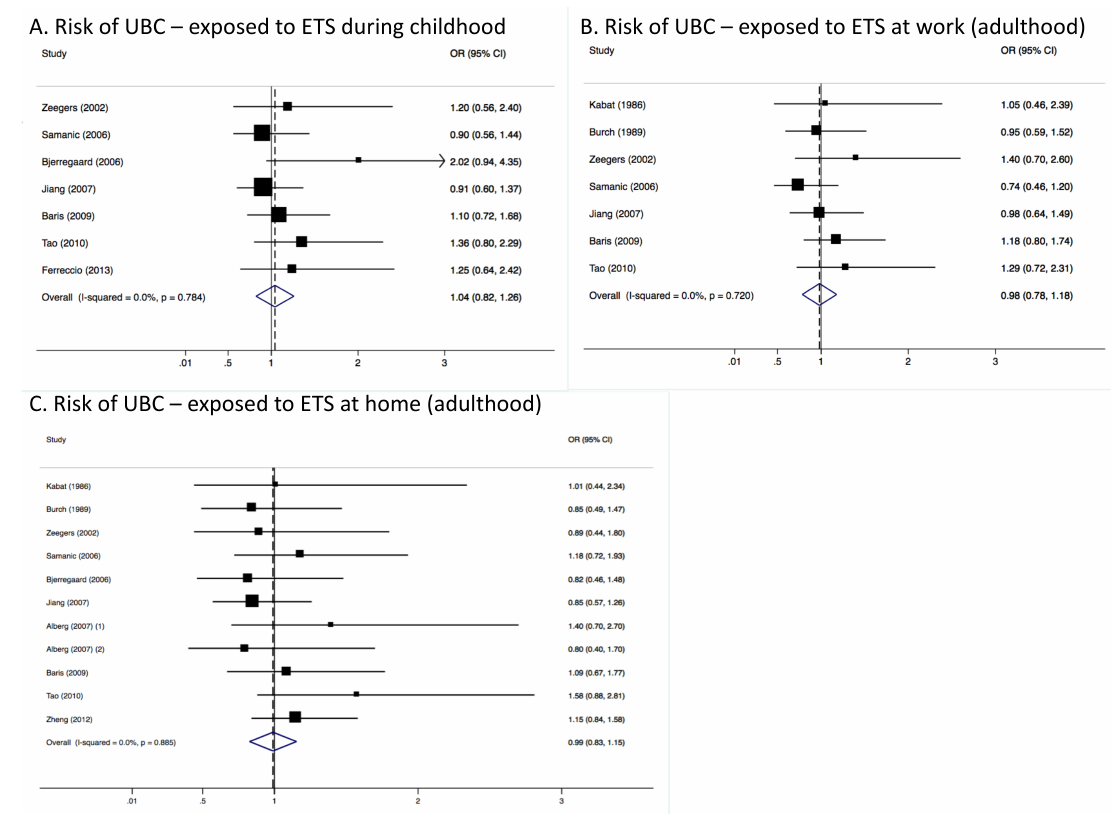
Figure 1. Meta-analysis results showing pooled risk estimates for urothelial bladder cancer (UBC) stratified by timing (childhood or adulthood) and location (work-related or domestic) of exposure to ETS for males and females